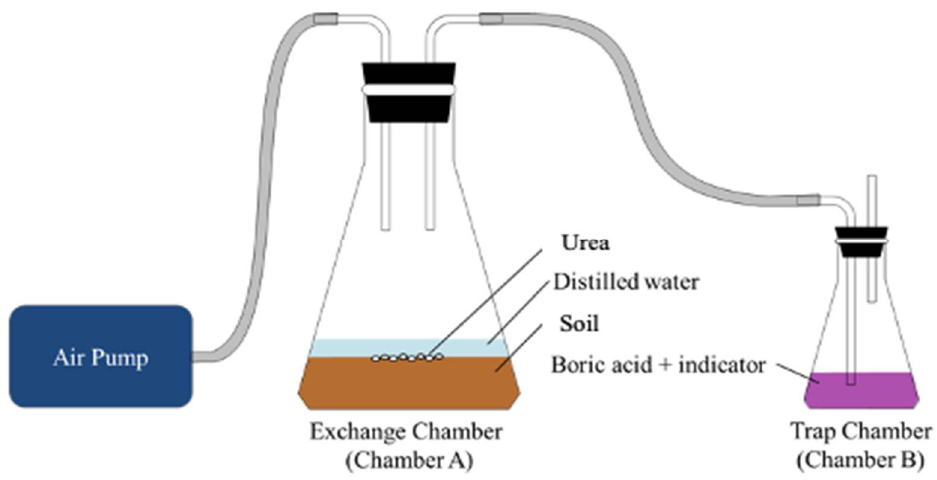
Figure 4. A closed-dynamic airflow system setup was used to estimate ammonia volatilization from uncoated urea and urea coated with rejected sago starch.